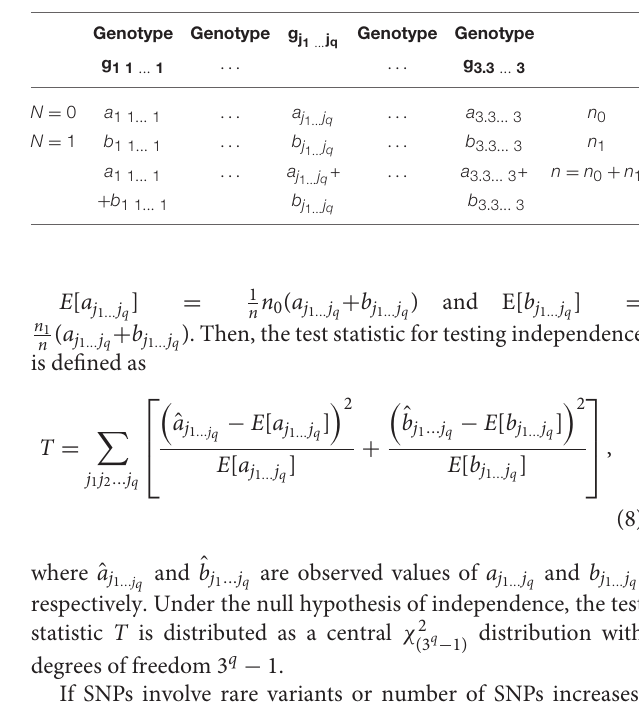
TABLE 1 | Contingency table for testing